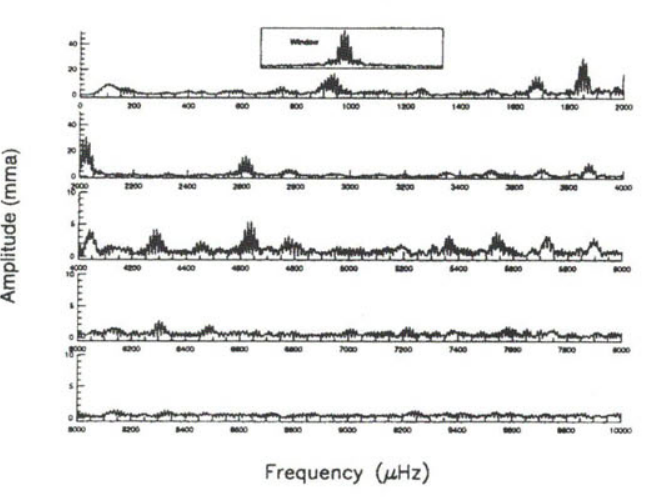
Fig. 16. The FT for the October 1990 data on HL Tau 76.